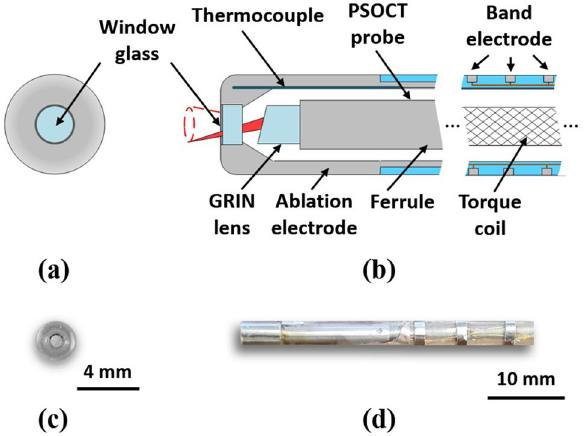
Figure 1. Diagrams and photographs of integrated PSOCT-RFA catheter tip. ( a , b ) are schematic drawings of the integrated catheter tip in front and cross-section views; ( c , d ) are photographs of the integrated catheter tip in front and side